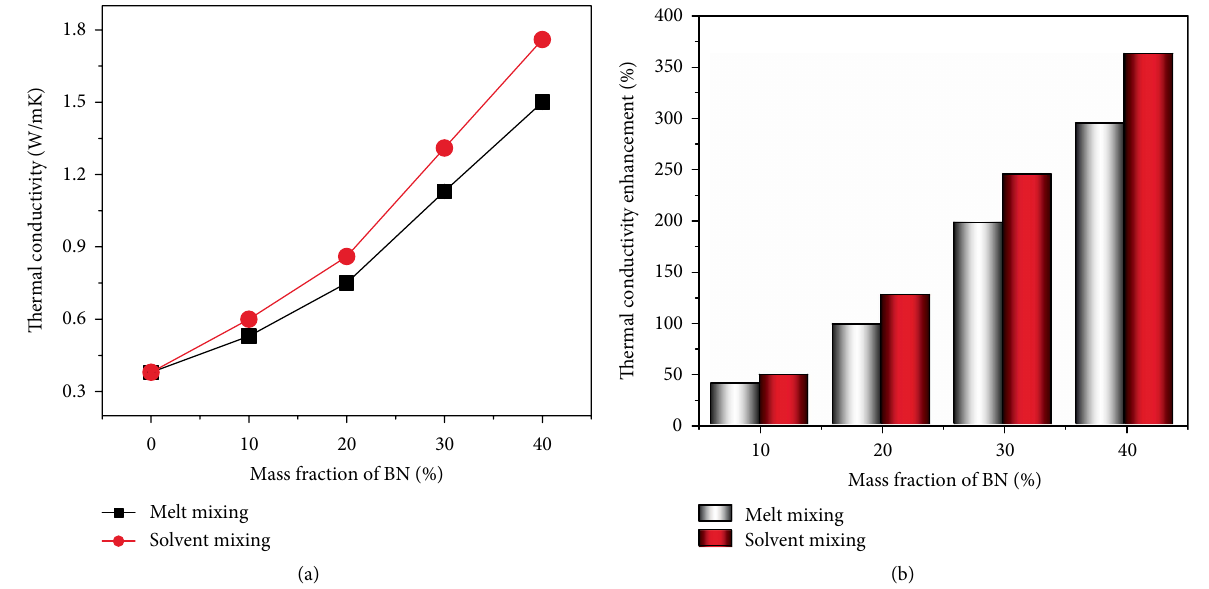
Figure 7: Thermal conductivity and enhencement of the UHMWPE/BN composites by melt mixing and solvent